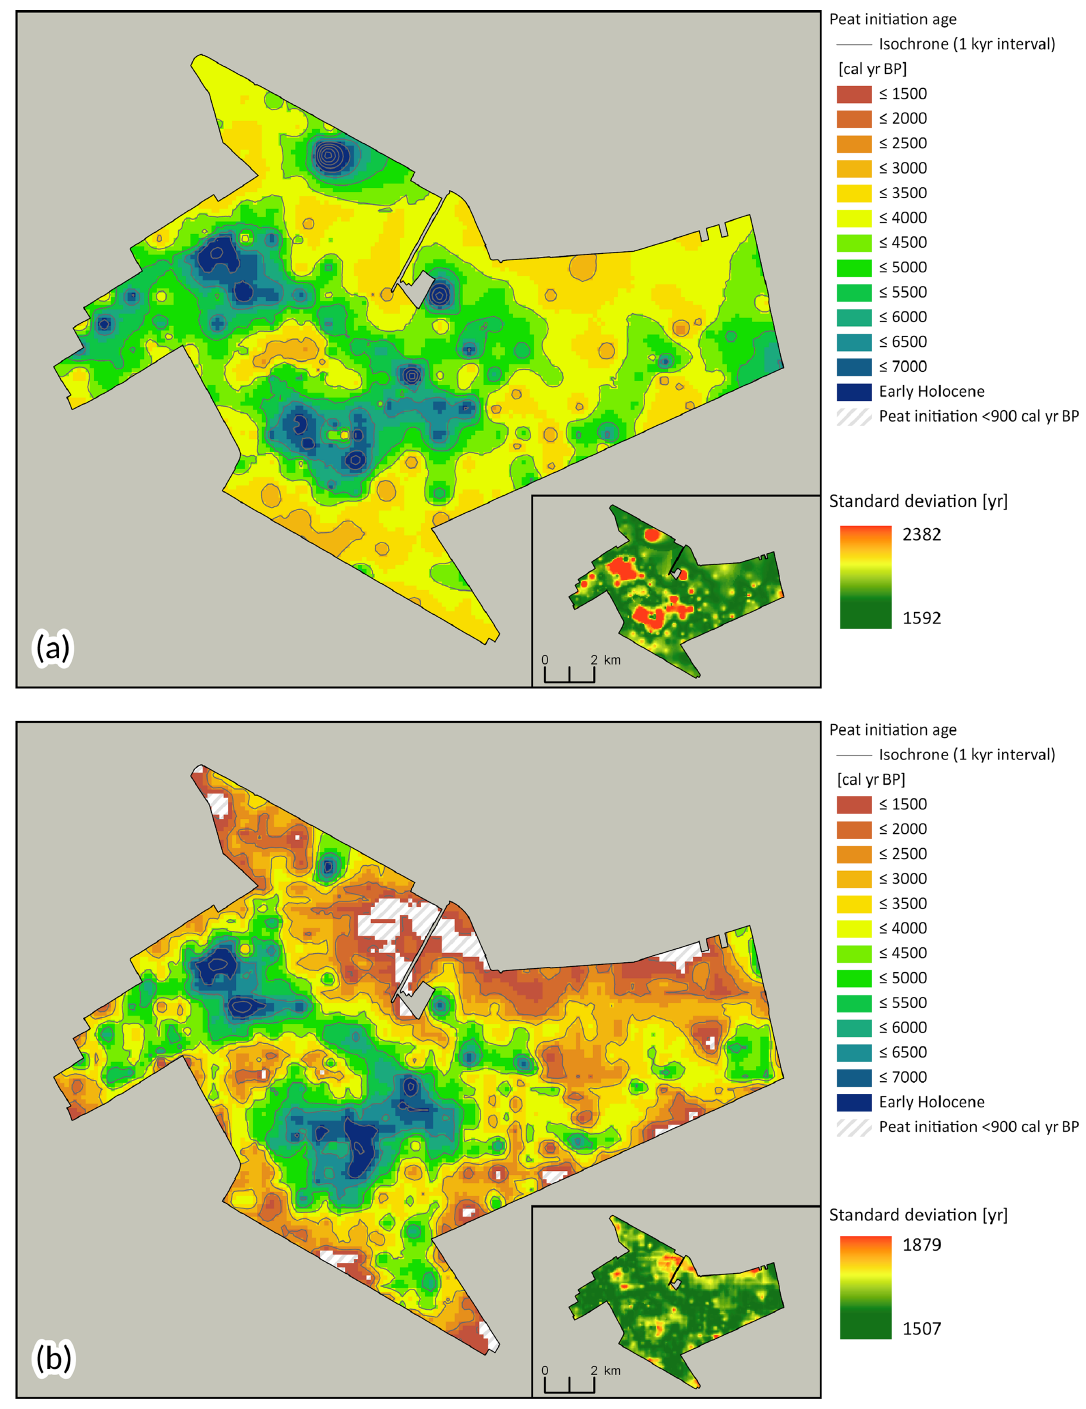
Figure 8. (a, b) Reconstructed peat initiation ages for Fochteloërveen, with (a) based on thickness of organic deposits [ O ] (see Fig. 7b) and (b) based on groundwater-fed wetness that results from geomorphological position [ z P H ] (see Fig. 7d). Contours represent isochrones (lines of equal age) and have an interval of 1000 years. Note that peat initiation age legends are equal, but legends of the standard deviation of the prediction